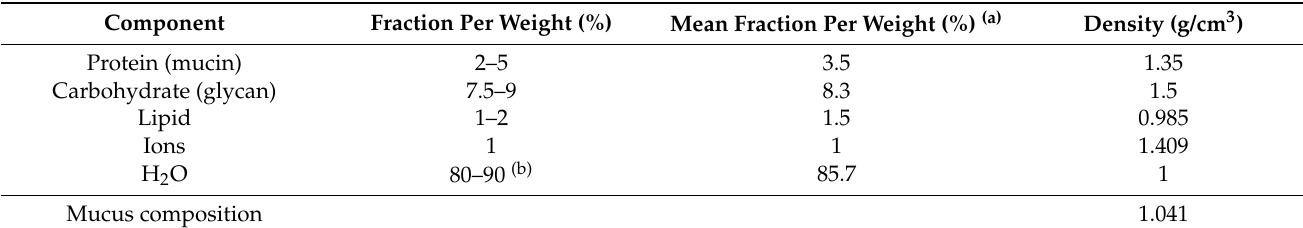
Table 1. Mucus definition from composition data.